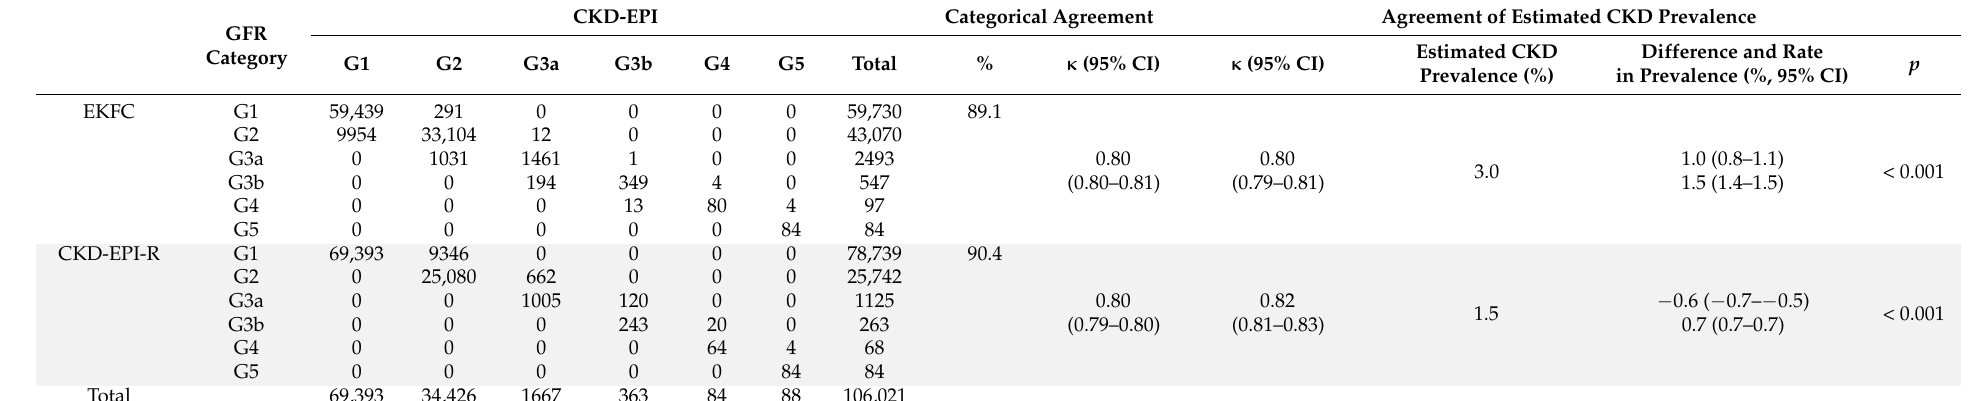
Table 2. Agreement of GFR categories among serum creatinine-based CKD-EPI, EKFC, and CKD-EPI-R